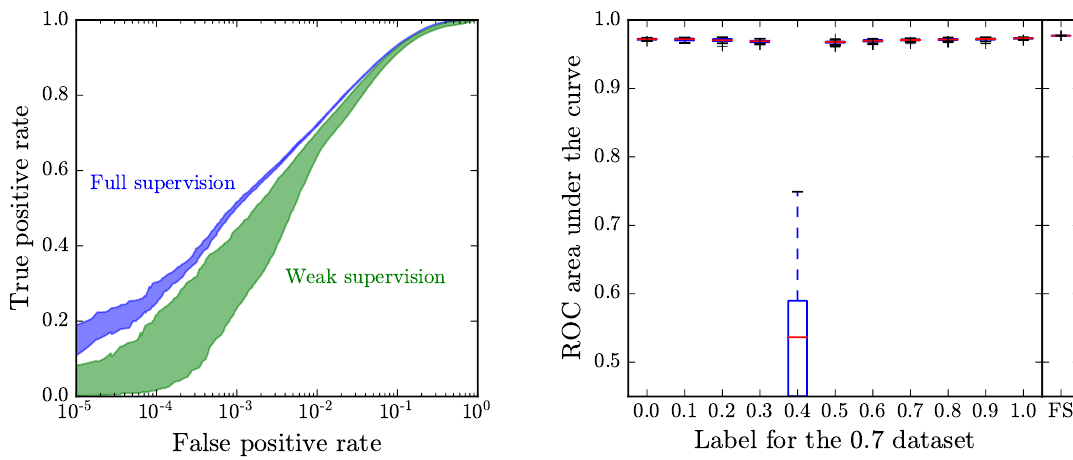
Label for the 0.7 dataset Figure 5 . The left panel shows the spread derived from the 100 networks trained to compute the error bars. We show the result for both fully and weakly supervised networks; for the later, the network is trained using the correct choice of 0.4 and 0.7 for the labels. The area under the curve is very similar for all of them, but the curves di(cid:11)er in their variance and at very low values of the false positive rate, demonstrating the possible spread in network performance trained on the same data. The right panel shows a comparison of the fully supervised network (labeled \FS") and the weakly supervised network when one of the datasets labels does not match its true ratio. One data set has a true ratio of 0.4 and is labeled as such. The other dataset has a ratio of 0.7, but the network is trained using the label as speci(cid:12)ed on the x